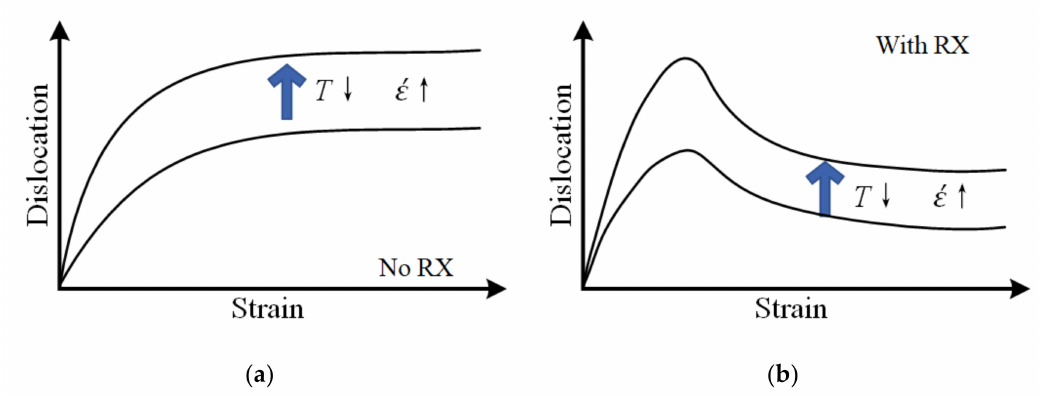
Figure 7. Schematic illustration of dislocation density evolution during deformation with ( a ) no recrystallisation and ( b )